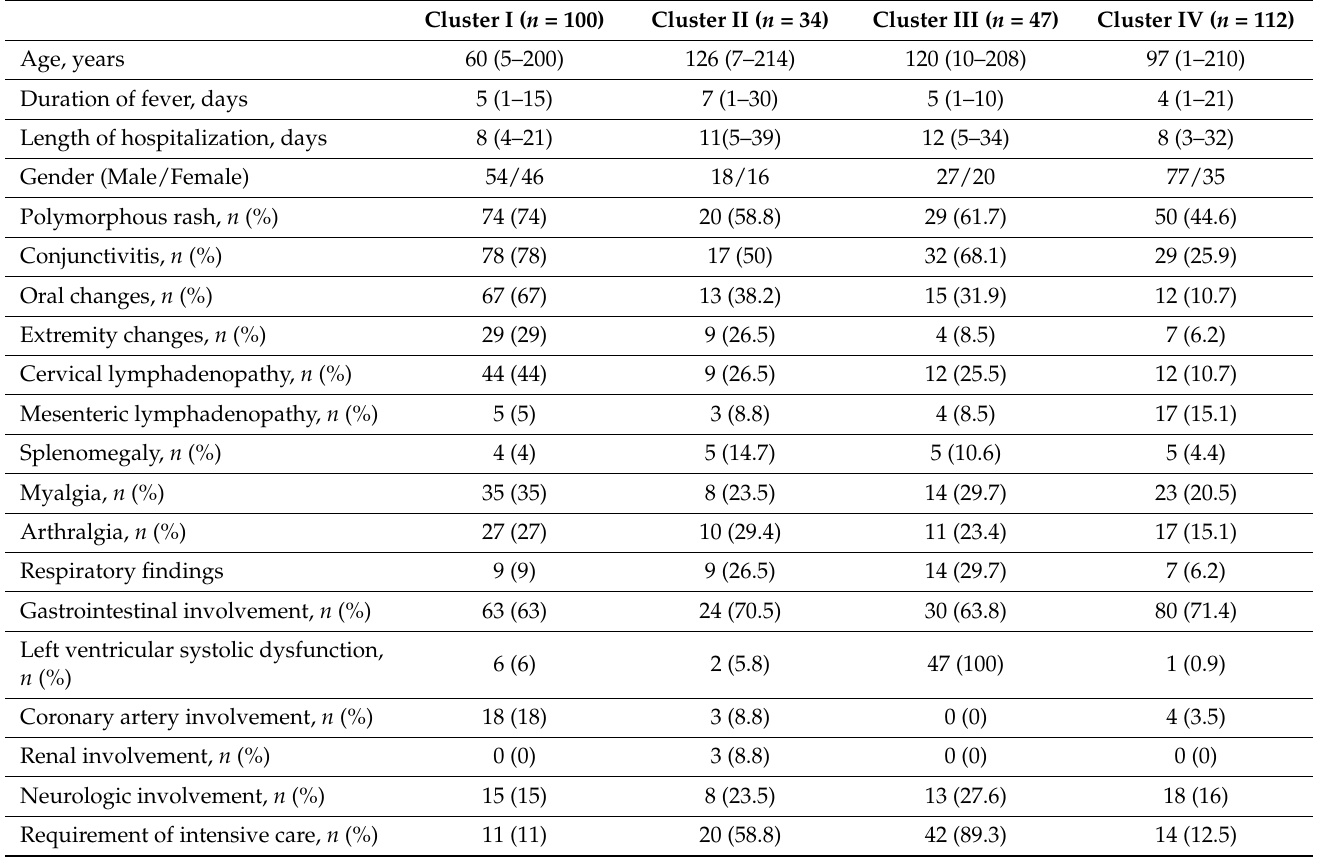
Table 3. The characteristics of the patients according to